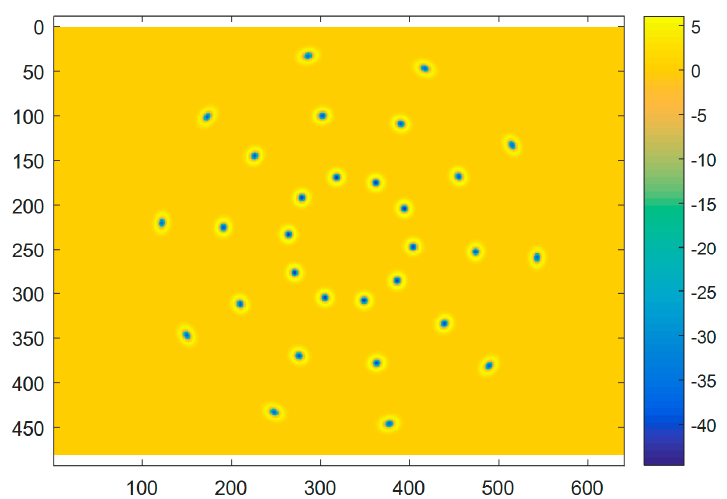
Figure 8. The LoG kernels of Equation (12) at different positions on the fisheye image.